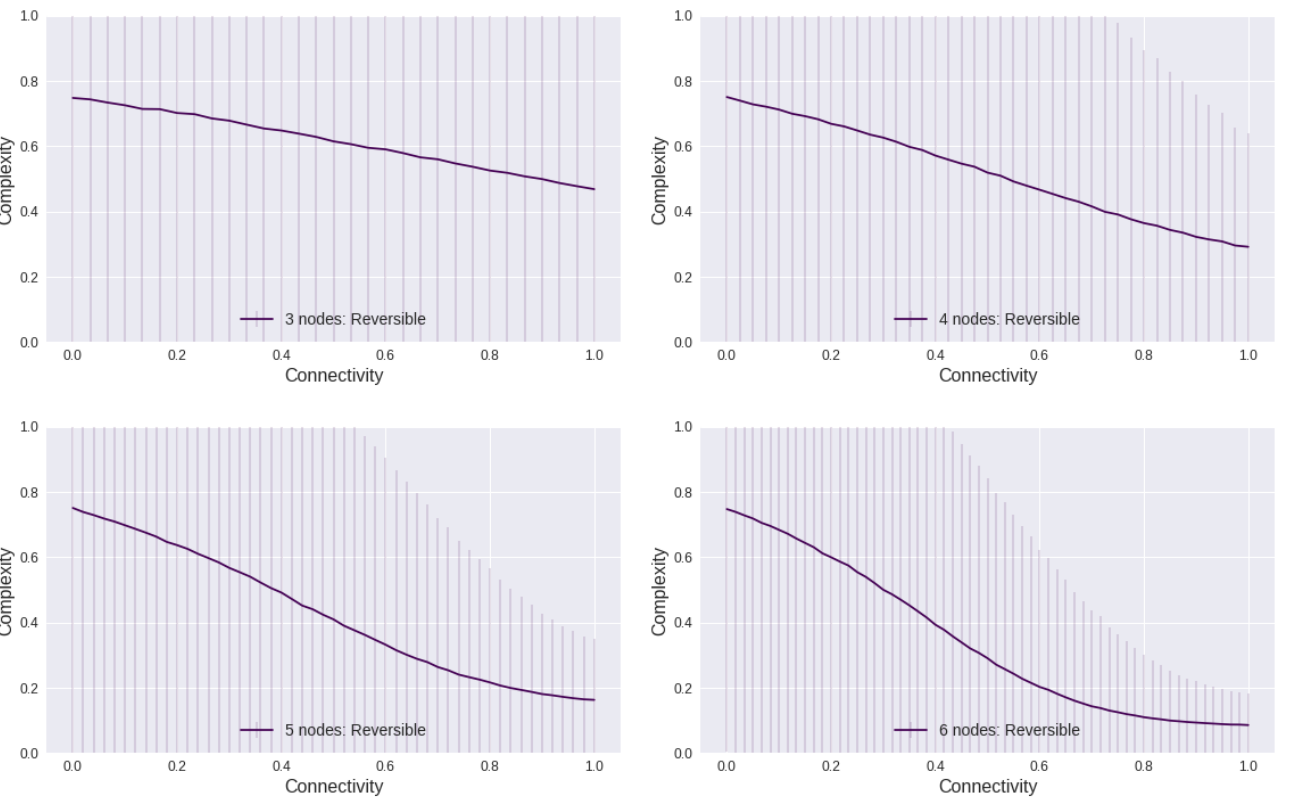
Figure A6. Complexity for RevBNs with 3, 4, 5, and 6 nodes. Connectivity is normalized from the range ( 1, N ) . The complexity was computed from 20,000